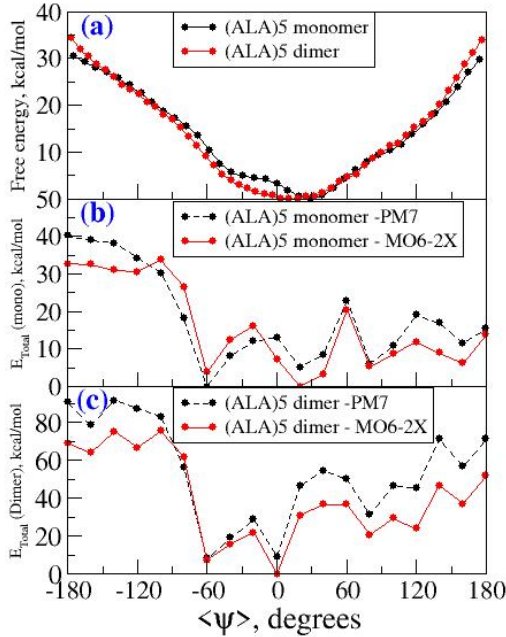
Figure 7. ( a ) Free energy profile as a function of < ψ > for penta-alanine in monomeric and dimeric form from wham analysis ( b ) Energy profile as a function of < ψ > for monomeric form of penta- alanine using PM7 and M06-2X level of theory ( c ) energy profile as a function of < ψ > for dimeric form of penta-alanine using PM7 and M06-2X level of theory.